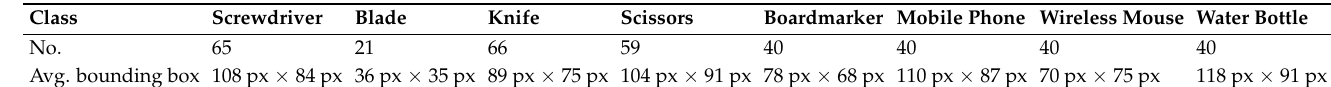
Table 1. Original terahertz image data.